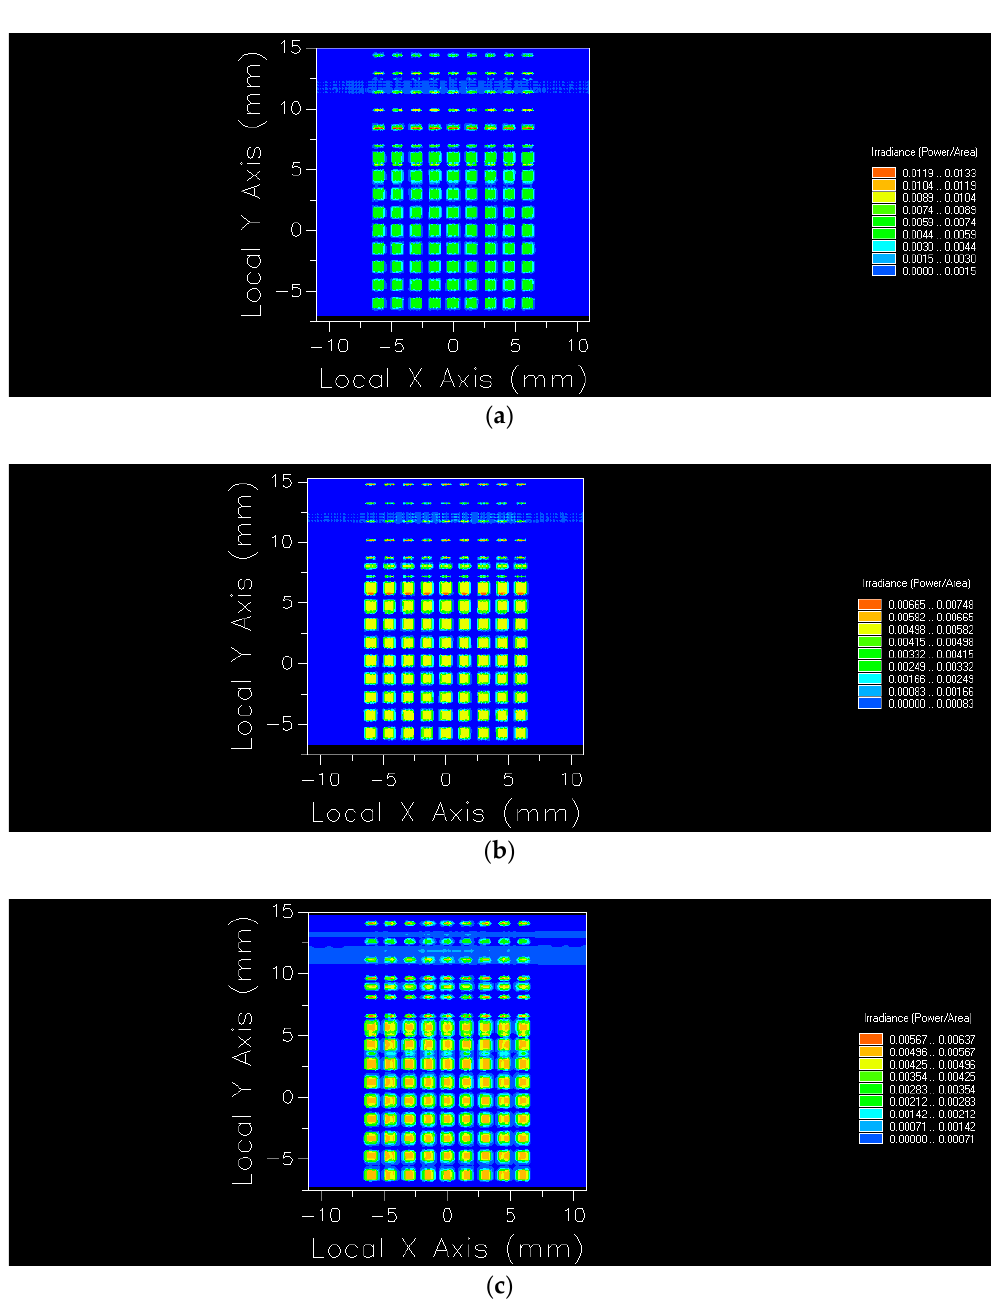
Figure 6. Imaging diagrams under different IFOV situations. ( a ) Y axis, δ = − 2°, θ = 0°, ( b ) Y axis, δ = − 2°, θ = 0.5°, ( c ) Y axis, δ = − 2°, θ = − 0.5°.